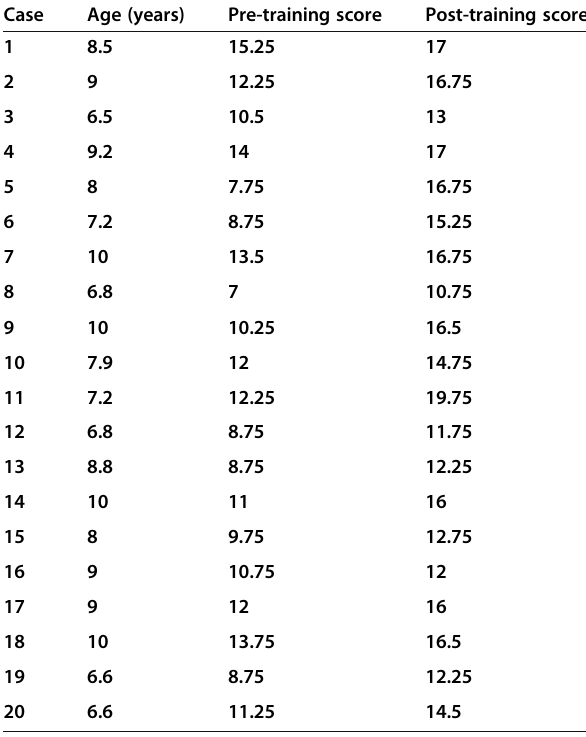
Table 2 The score of the Dysgraphia Disability Scale for each child pre- and post-training